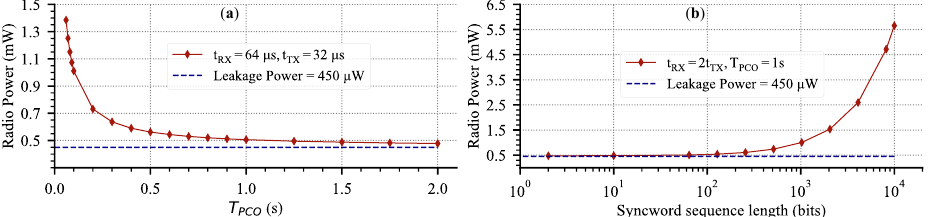
Figure 10. Estimated AD9364 radio power using datasheet values for a 2MSPS data rate, 10MHz bandwidth at 2.4GHz, 7dBm output power. ( a ) Power vs. PCO period for a 64-bit syncword sequence. ( b ) Power vs. syncword length for a fixed PCO period.